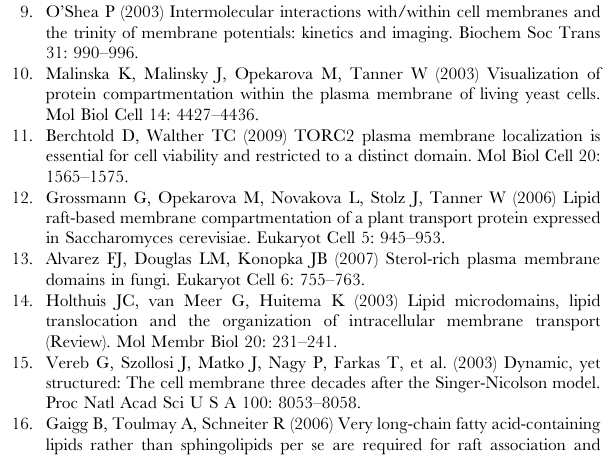
correspond to dependent variables and rate constants, respectively. The key for the variable names is given in Tables S1 and S2 . Rows not presented have only values smaller than one. Table S10 Simulation of the effect of statins in the SL-E model. The total mass of ergosterol (Erg.) and complex sphingolipid (CS) sub-populations in the flux balanced SL-E model is presented under different experimental conditions, after 120 minutes. Wild type condition is represented by the basal values; the two experimental conditions correspond to: A ) fold changes with respect to their corresponding basal values after decreasing the specific activity of Thiolase/Synthase and HMG Reductase to 10%, 1%, and 0.01%. B ) Same conditions as in A but with an simultaneous decrease to 1% the activity of IPC Synthase ( X 133 ). Complex sphingolipids: IPC, MIPC, and M(IP) 2 C in Golgi compartment (Golgi CS), or plasma membrane (PM). Last row correspond at the result of divide the DIM ergosterol, and the PM CS’s. (PDF) Table S11 Variables equivalence from Plas [ 48 ] into Matlab H [ 49 ] . (PDF) Equations S1 GMA mass equations for pools of total masses. In these equations, a superscript indicates fluxes for the complex sphingolipids that were not represented in Figs. 1 and 2 of the manuscript due to lack of space. (PDF) Equations S2 Power-Law terms from Equations S1 . In these equations, a superscript indicates fluxes for the complex sphingolipids that were not represented in Figs. 1 and 2 of the manuscript due to lack of space. (PDF) Equations S3 GMA mass balance equations for labeled pools. The structures of the mass balance equations are similar to the Equations in S8, but for clarity we use dL i = dt instead of dX i = dt and l i , j instead of v i , j . (PDF) Equations S4 Terms from Equations S3 . A superscript indicates deviations from the total pool; the method automatically computes equations for the labeled fractions. (PDF)